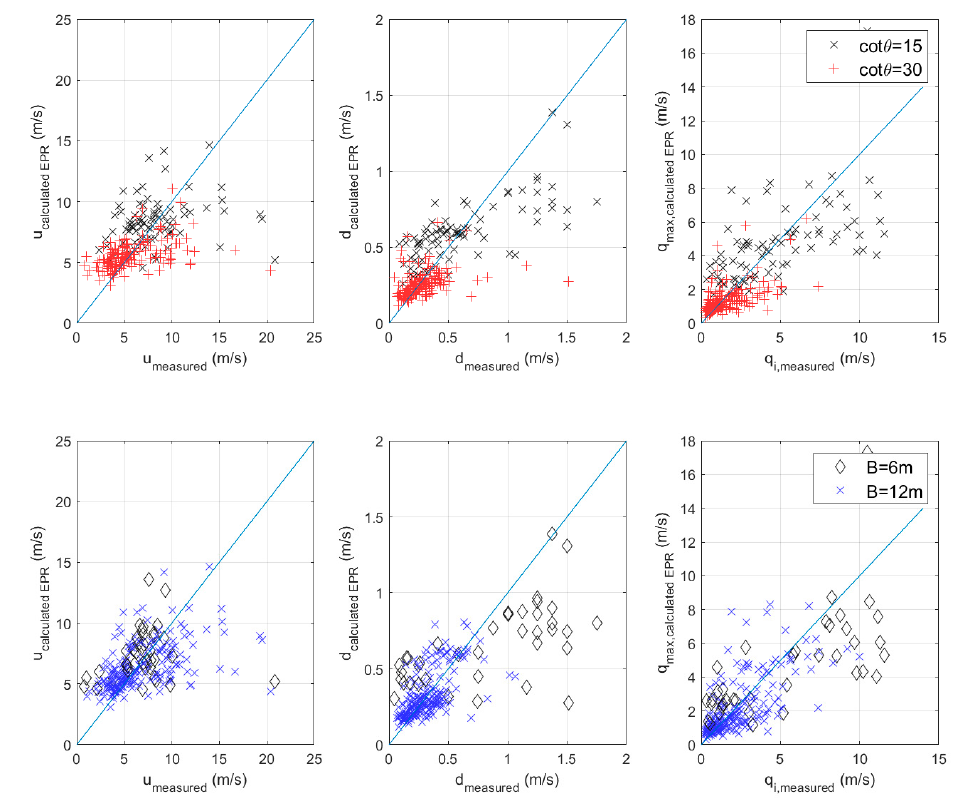
Figure 18. EPR results for overtopping flow properties on the dike crest versus measured ones.